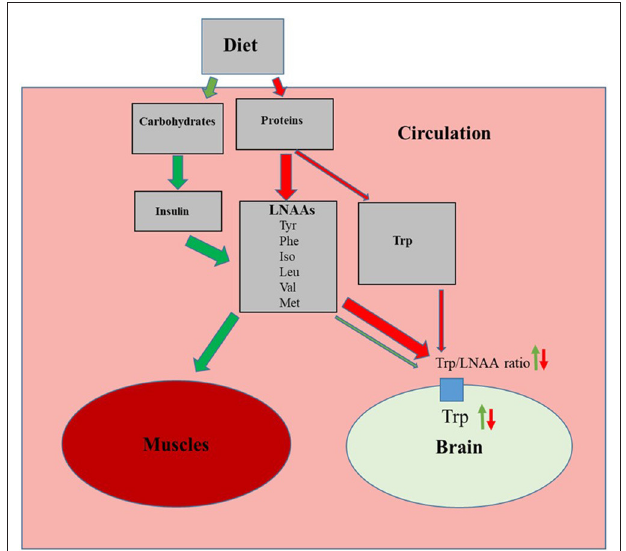
FIGURE 2 | Effects of the proteins and carbohydrates on influx of tryptophan (Trp) to the brain. Green arrows indicate activation of carbohydrate induced pathway, resulting increased muscle uptake of large neutral amino acids (LNAAs; Tyr, tyrosine; Phe, phenylalanine; Iso, isoleucine; Leu, leucine; Val, valine and Met, methionine) which in turn increases plasma Trp/LNAA ratio and brain Trp levels. Red arrows indicate how a normal dietary protein source, with relatively low Trp content, decreases the plasma Trp/LNAA ratio and brain Trp